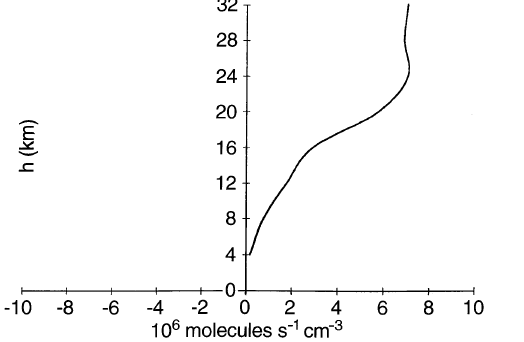
Fig. 4. 24 December 1992; contribution of zonal advection to the local variation of the ozone concentration as a function of height (cid:51)(cid:46)(cid:50) (cid:54) (cid:77)(cid:97)(cid:114)(cid:99)(cid:104) (cid:49)(cid:57)(cid:57)(cid:51) The negative horizontal advection along the y direction (northward) seems to be the cause of the decreasing O (cid:51) ( ! 46.3 (cid:93) 10 (cid:54) moleculescm (cid:126)(cid:51) s (cid:126)(cid:49) ). As a matter of fact, a strongly negative meridional gradient of ozone is clearly visible in the map (Fig. 5). The 300-hPa field (Fig. 6) is